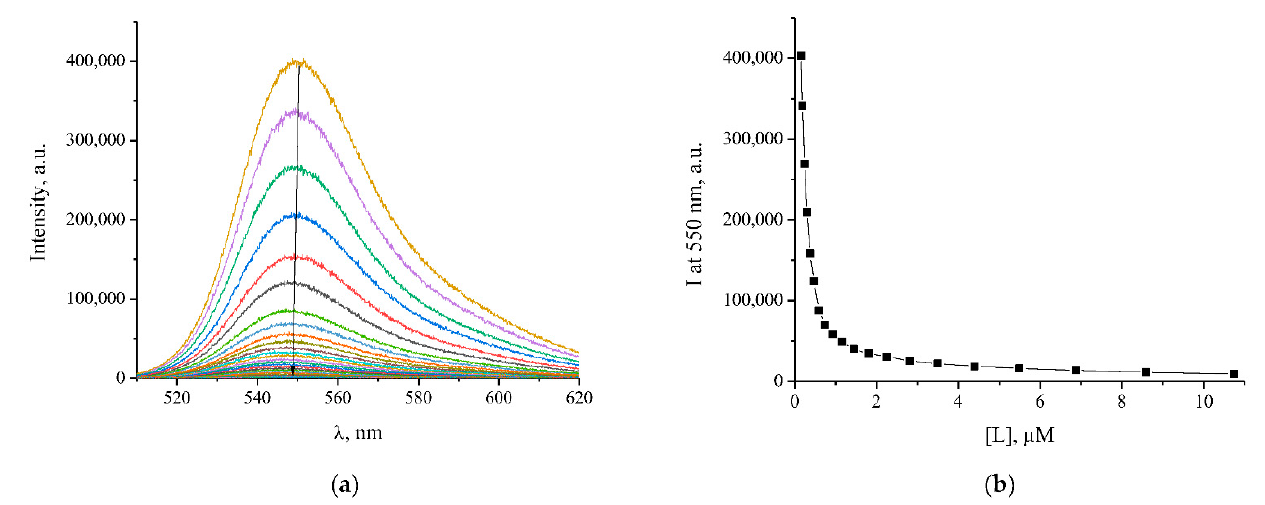
Figure 3. Direct fluorescence titration of Rh6G (1.0 μ M) with L (up to 10.7 μ M) ( a ) in PBS buffer (pH 7.4) at 37 °C and the associated titration curve ( b ) at λ em = 550 nm.